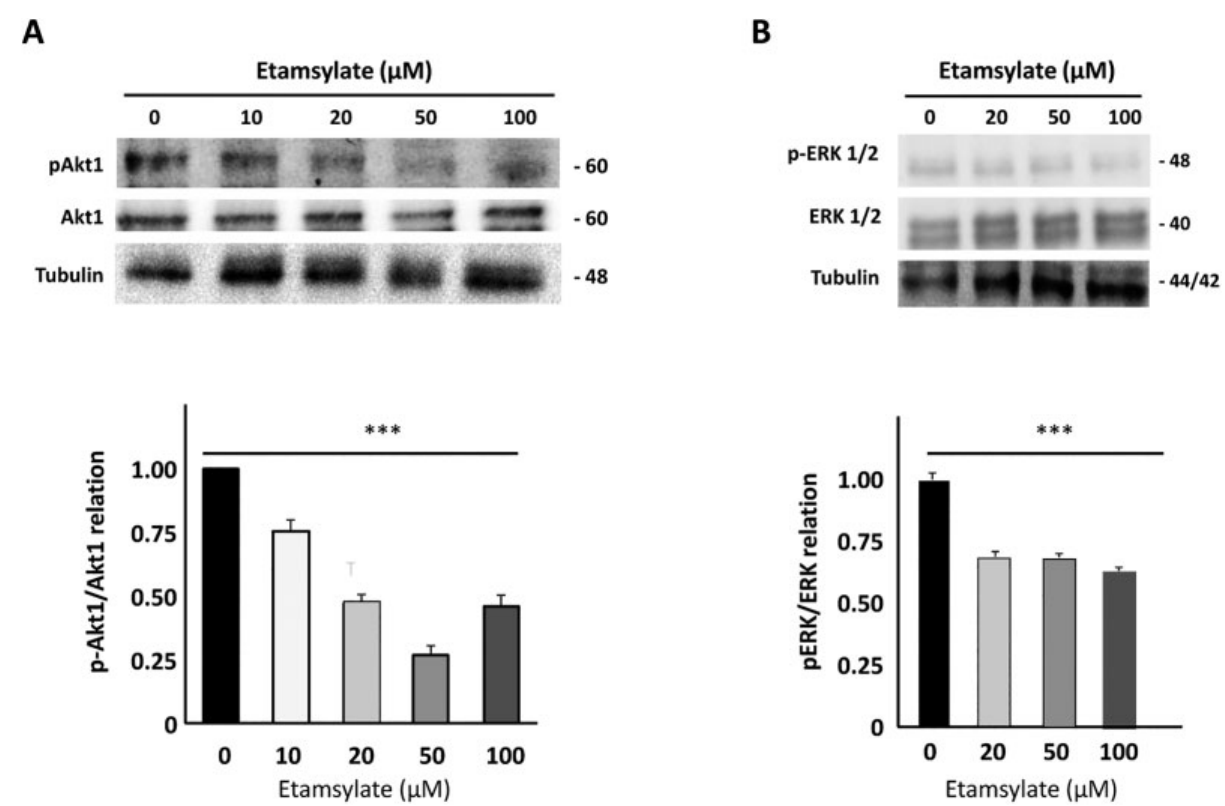
Fig. 6 Analysis of Akt and Erk1 phosphorylation after etamsylate treatment. ( A ) Analysis of pAkt1, Akt1, and tubulin in cell lysates in HUVECs. A representative gel of three experiments performed is shown. Bands were quanti fi ed by Adobe Photoshop CS. Relative levels of pAkt1 normalized versus total Akt1. A decrease of the amount of phosphorylated protein is apparent compared with control. ( B ) Relative levels of pERK2 normalizedversus total erk. pERK2 levelsdecrease whencells weretreatedwith thehighest doses ofetamsylate (50 – 100 μ M) compared with the control. HUVECs, human umbilical vein endothelial cells.